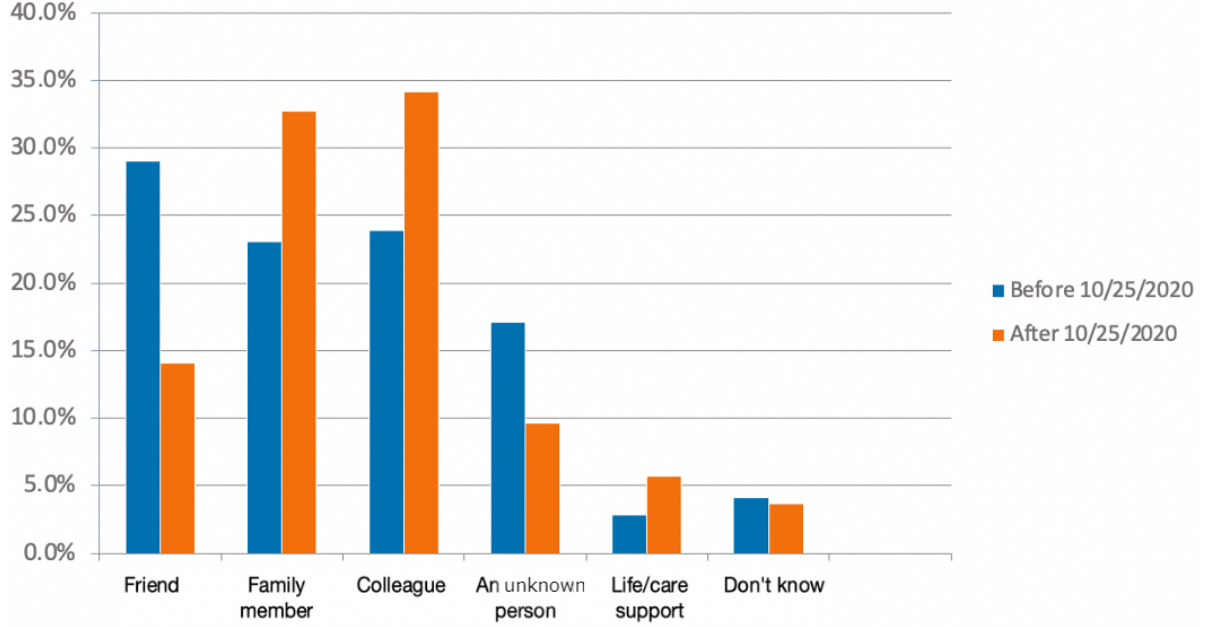
Figure 2. Contamination circumstances before versus after the partial lockdown, which was triggered in France on October 25, 2020. Answer to the question “Who contaminated you or your close relative?” ( P